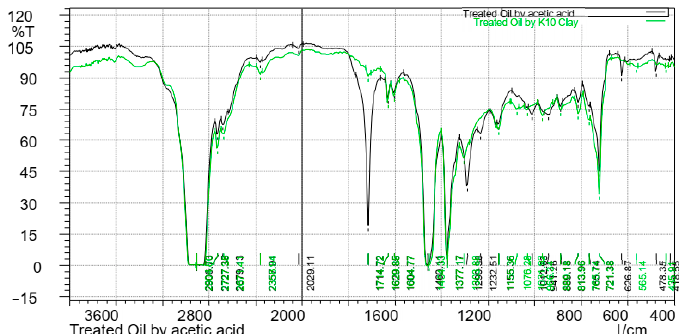
Figure 10. Superposition of IR spectra: oil treated with acetic acid and oil treated with K10 clay.